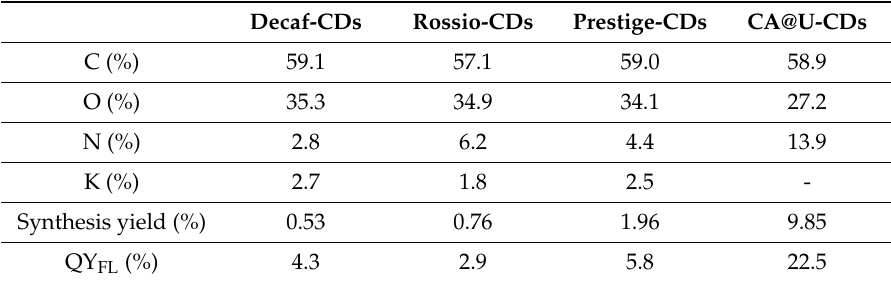
Table 1. Atomic surface compositions (%) *, synthesis yields (%), fluorescence quantum yield (QY FL ) (%) for decaf-carbon dots (CDs), rossio-CDs, prestige-CDs and